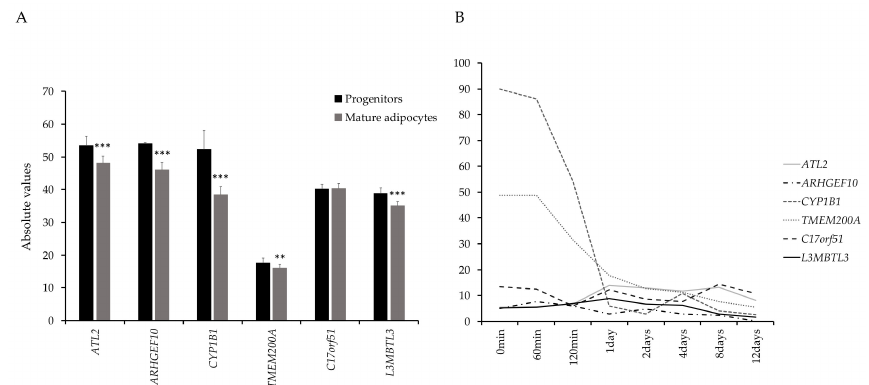
Figure 2. ( A ) Enrichment of candidate genes in progenitor cells and mature adipocytes. Data retrieved from the FANTOM5 dataset (http: // fantom.gsc.riken.jp / 5 / ) and Ehrlund, A et al. 2017 [29]. ( B ) Expression of candidate genes during human mesenchymal stem cell (hMSC) di ff erentiation in